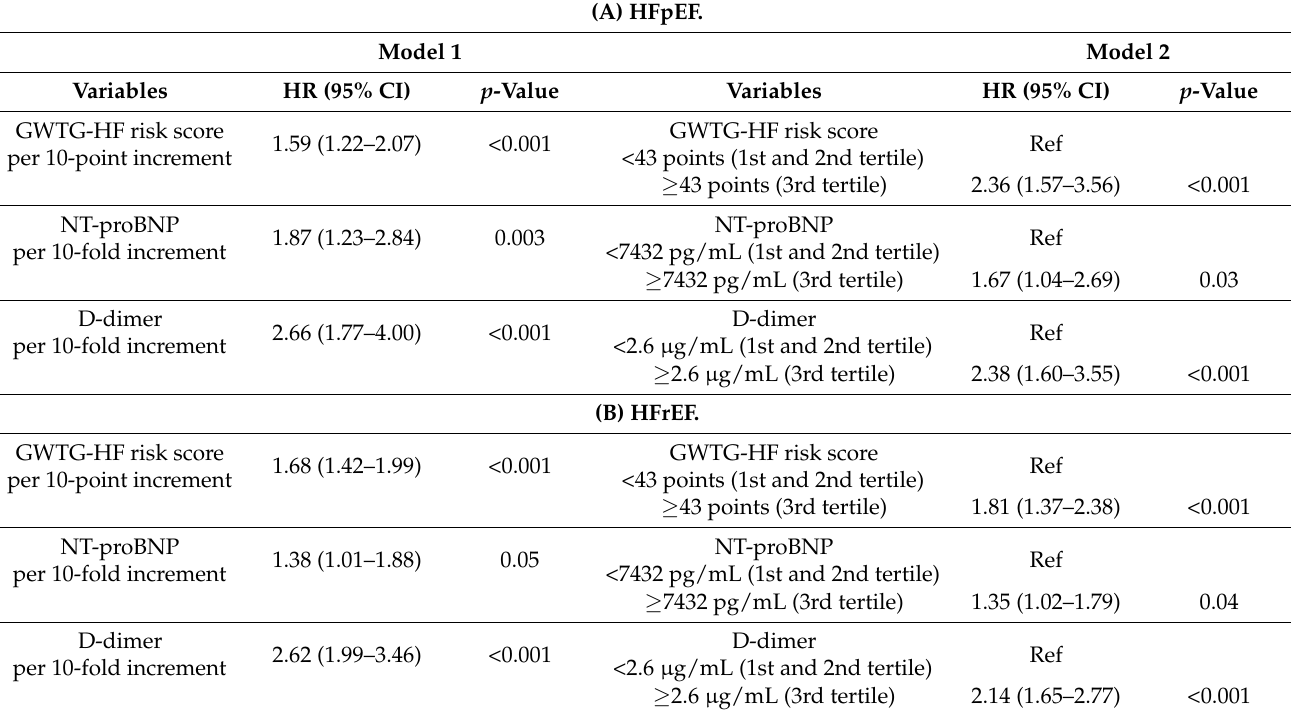
Table 3. Multivariate predictors of all-cause mortality in HFpEF (A) and HFrEF (B) patients.